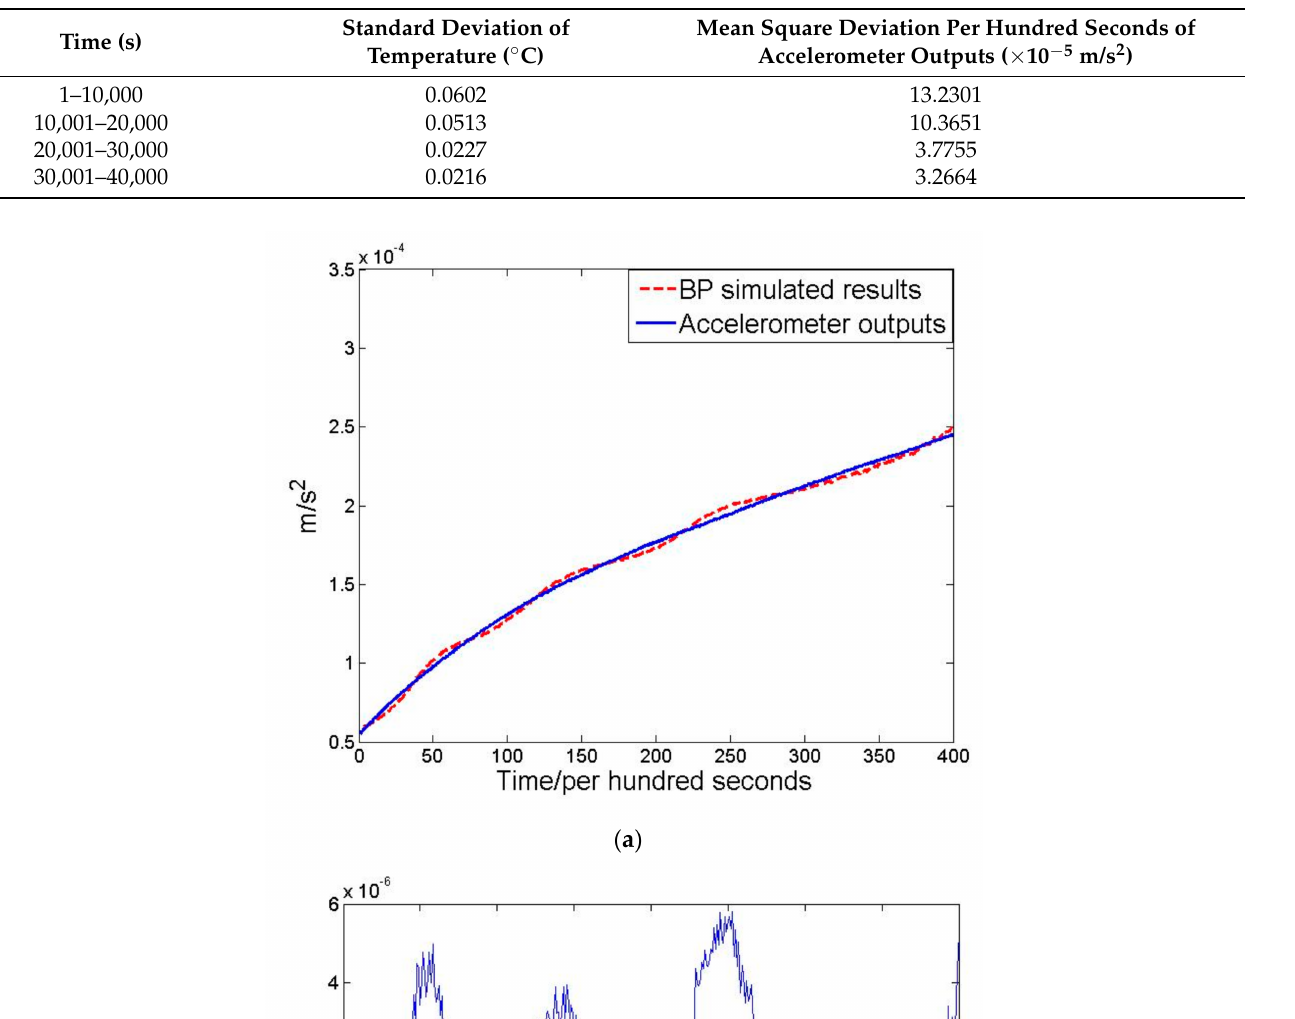
Table 1. The standard deviation of temperature and the mean square deviation per hundred seconds of accelerometer.